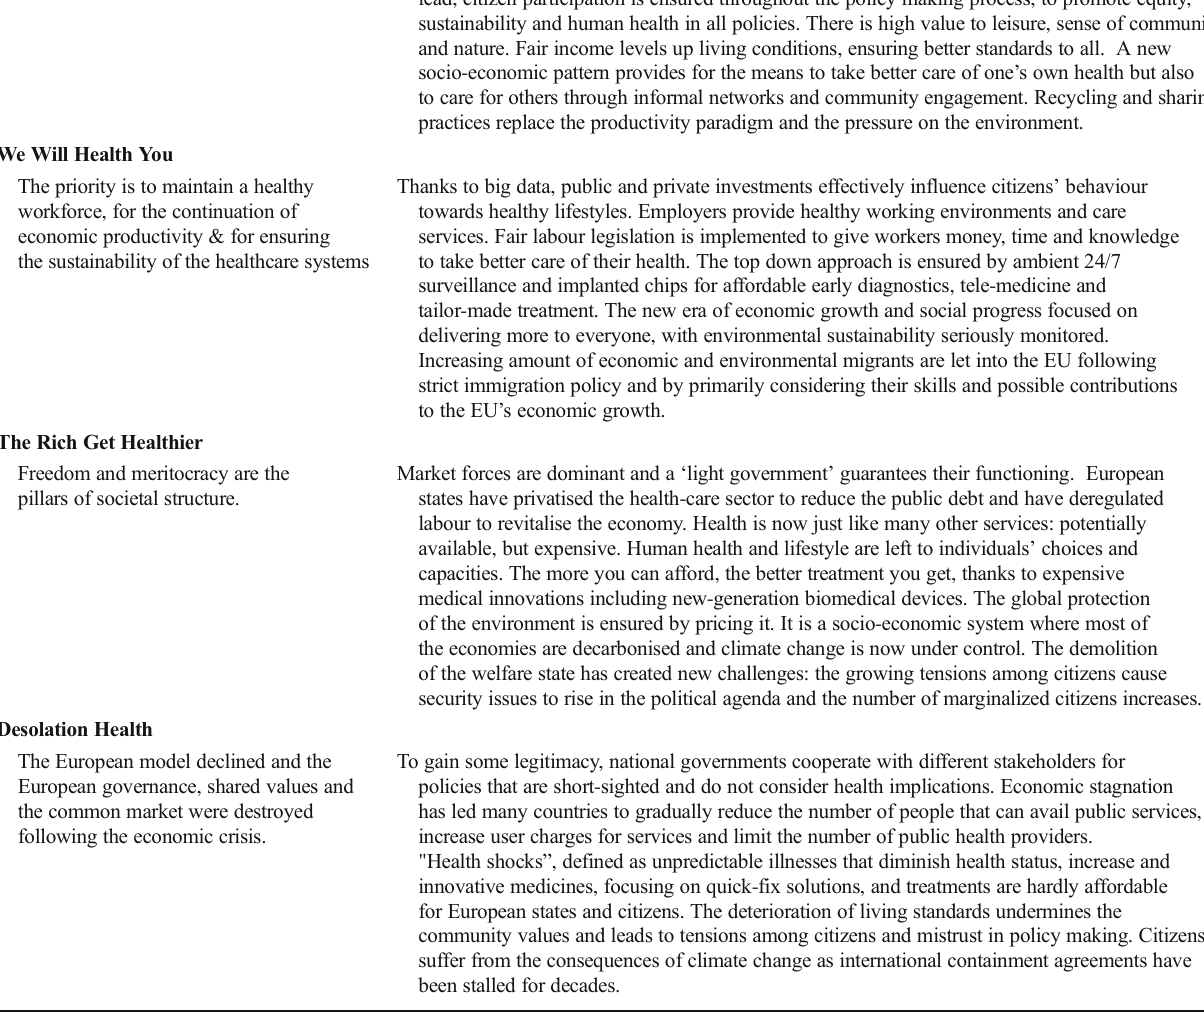
Short descriptions of FRESHER Scenarios [17] Healthy